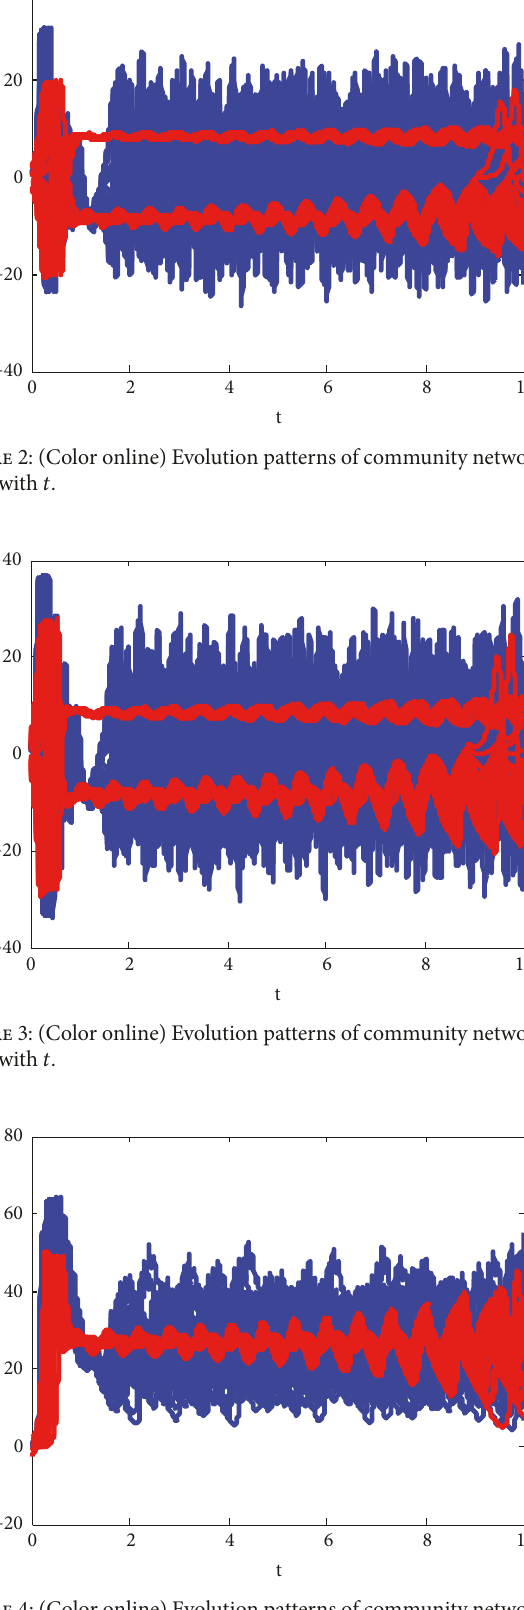
Figure 7: (Color online) Evolution curves of state variables 𝑧 𝑖3 (𝑡) after adding